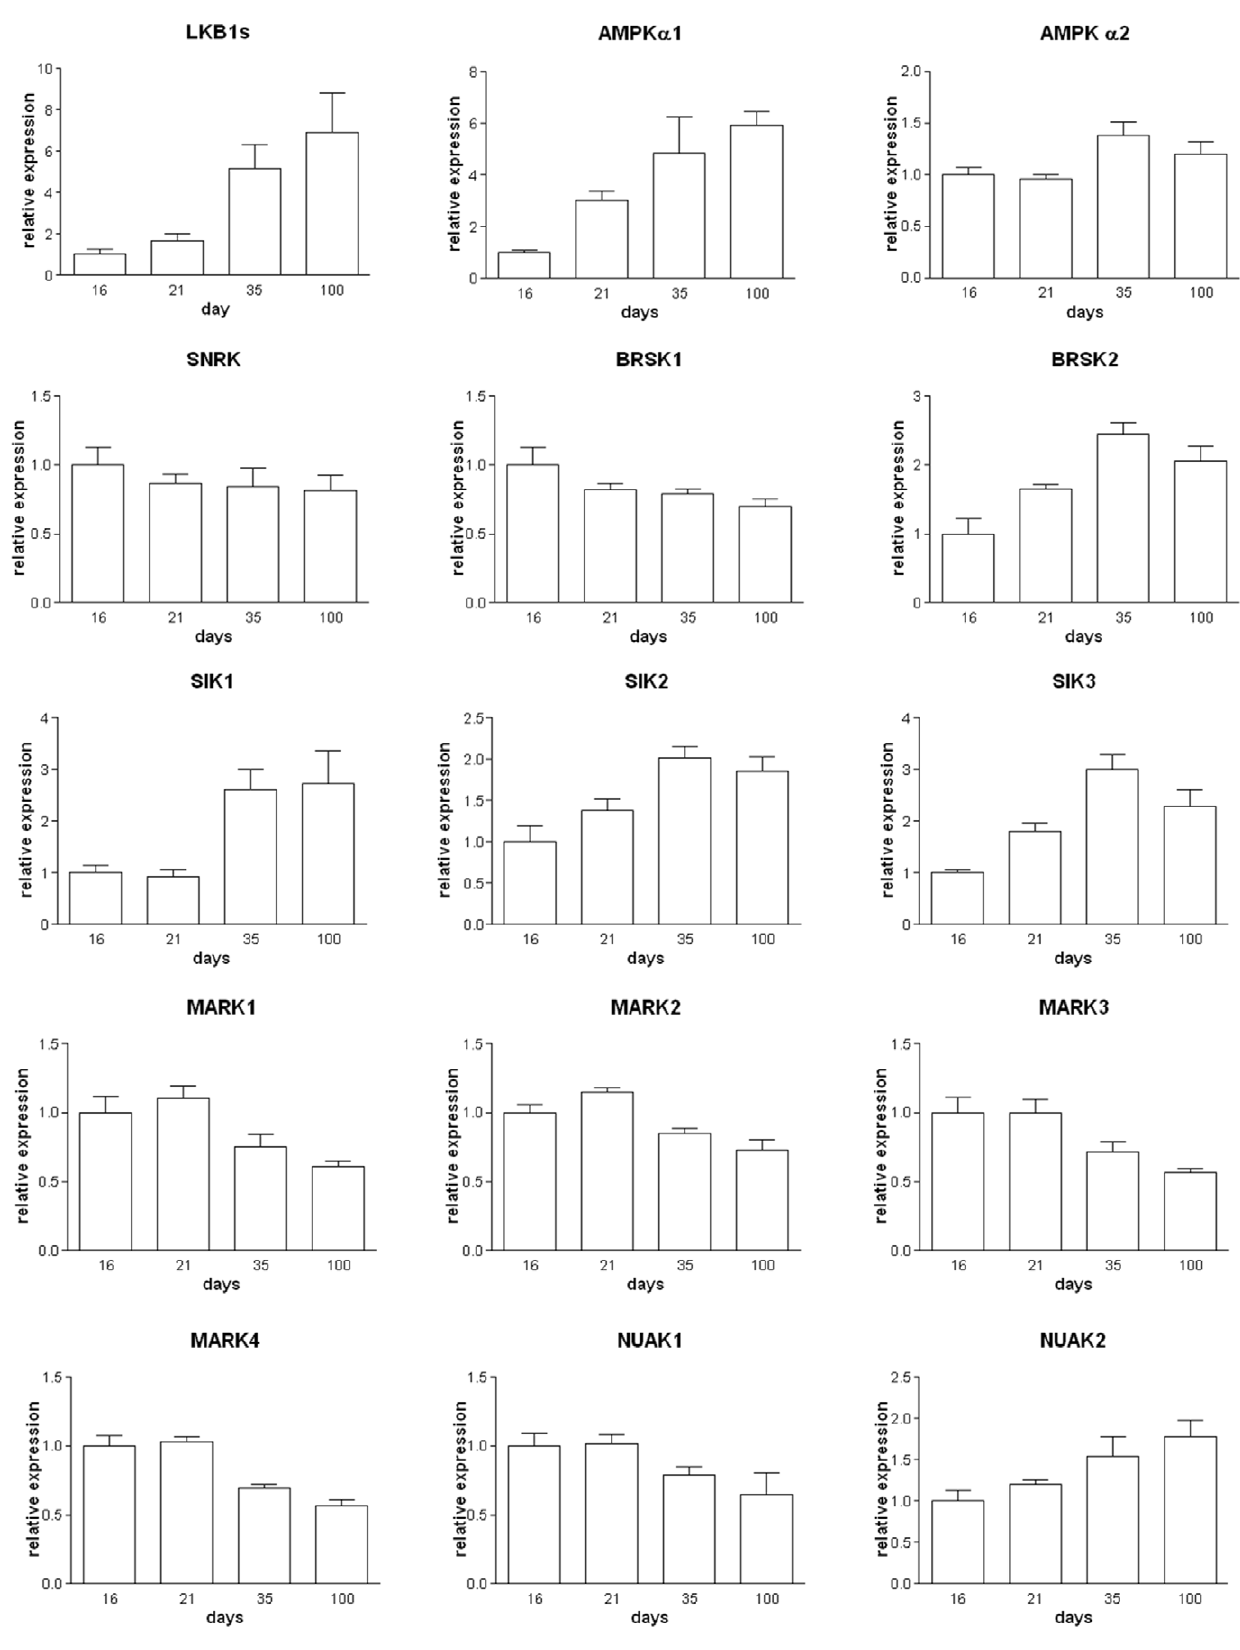
Figure 8. Expression of AMPK and AMPK-related kinases in testis. The mRNA expression levels of LKB1 and downstream kinases in developing testis at post-partum days 16–100. Values are shown relative to the expression levels at day 16 and shown as the mean + /- SEM, n=5. doi:10.1371/journal.pone.0028306.g008 PLoS ONE |